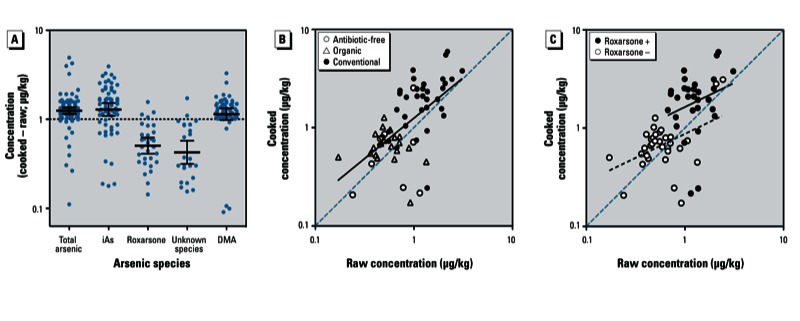
Results showing comparisons between cooked and raw sample pairs. (A) Means and 95% CIs for arsenic species for the difference between pairs of cooked and raw samples. (B,C) Scatter plots showing the effect of cooking on iAs concentration by package label (B) and by roxarsone presence (+) or absence (–) (C).